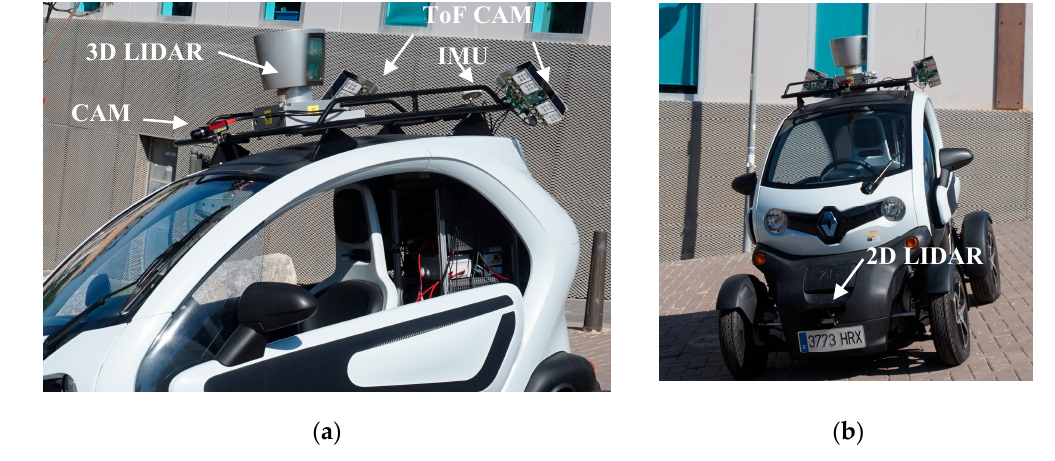
Figure 3. Sensor system on-board the car roof ( a ), and front ( b ) of the CIC.